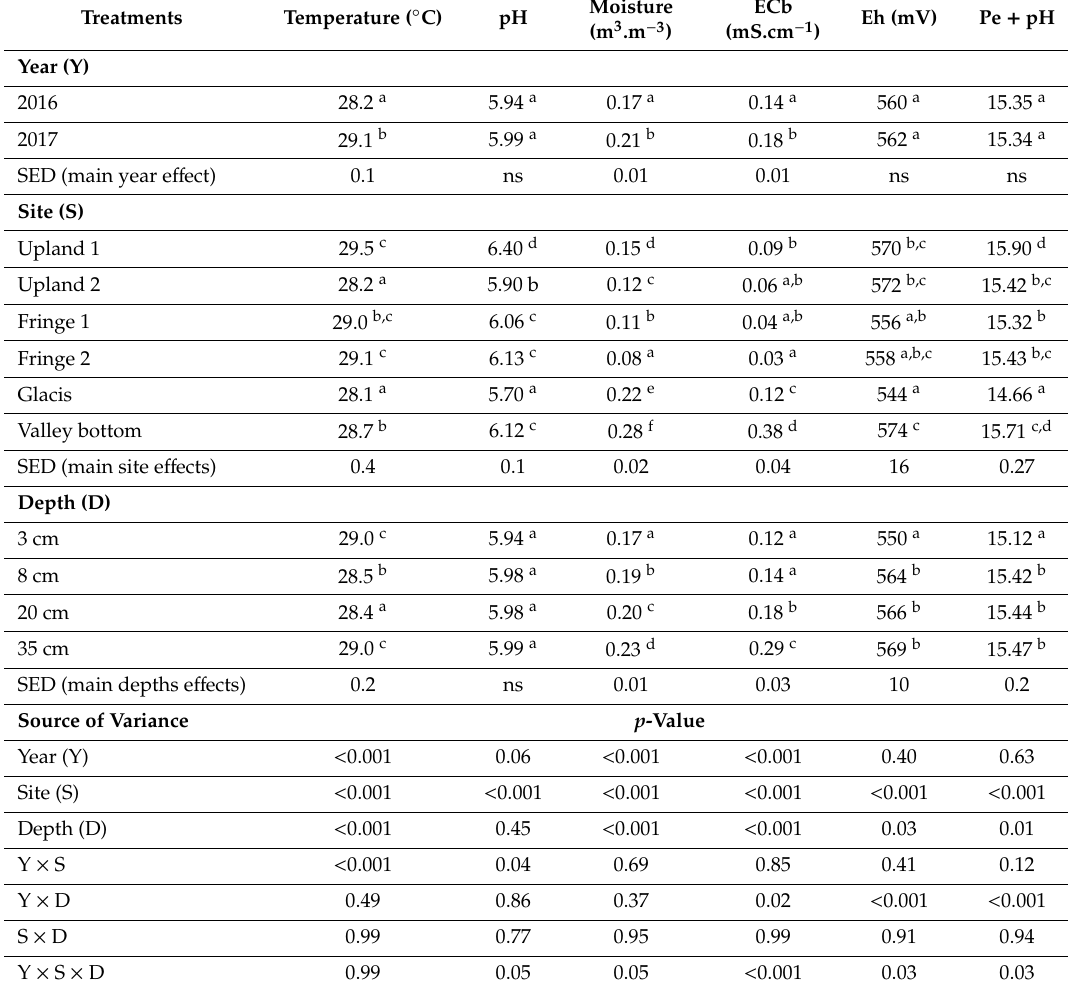
Table 2. Average soil electrochemical characteristics at di ff erent soil depths of the experimental sites.